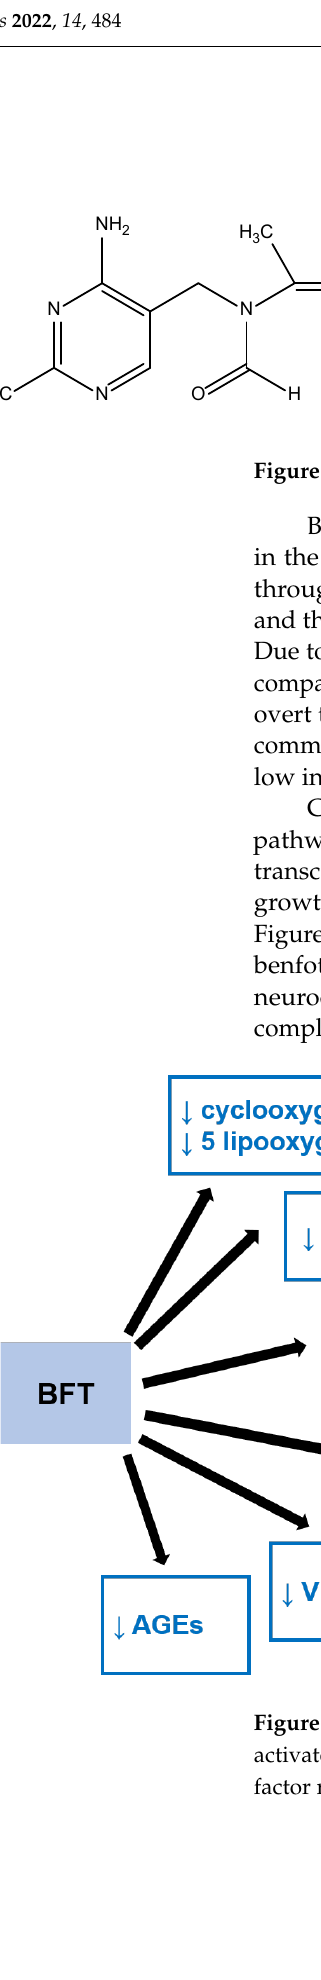
Figure 6. Other effects of benfothiamine. NF- κβ, nuclear transcription factor κB; MAPK, mitogen- activated protein kinases; GSK 3, glycogen synthase kinase-3; VEGFR2, vascular endothelial growth factor receptor 2; AGEs, advanced glycation end-products.